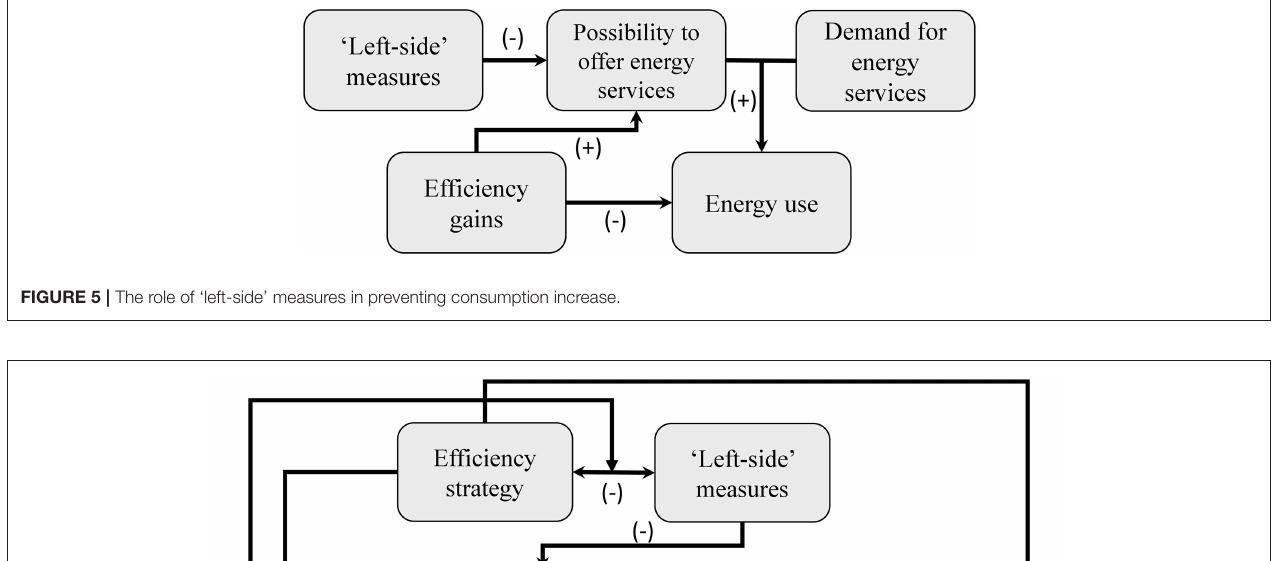
is required to be satisfied by “right-side” measures.